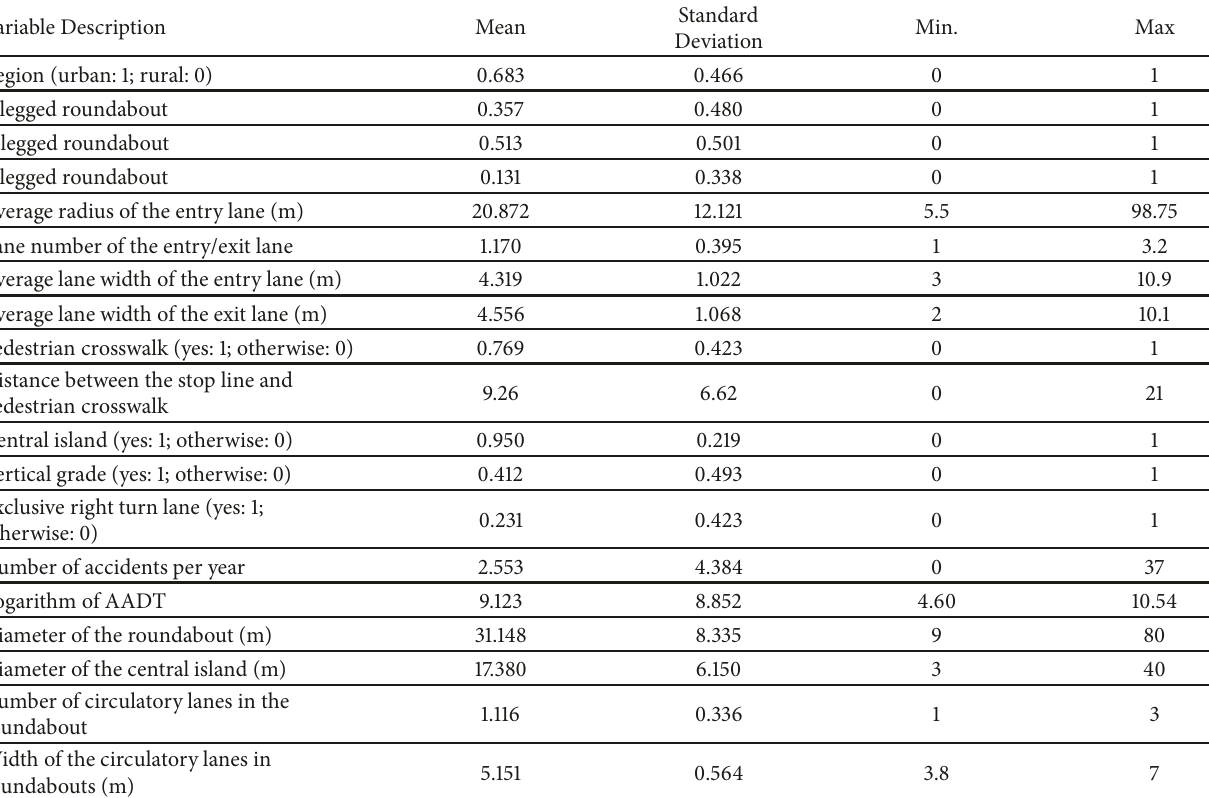
Table 4: Descriptive statistics of the